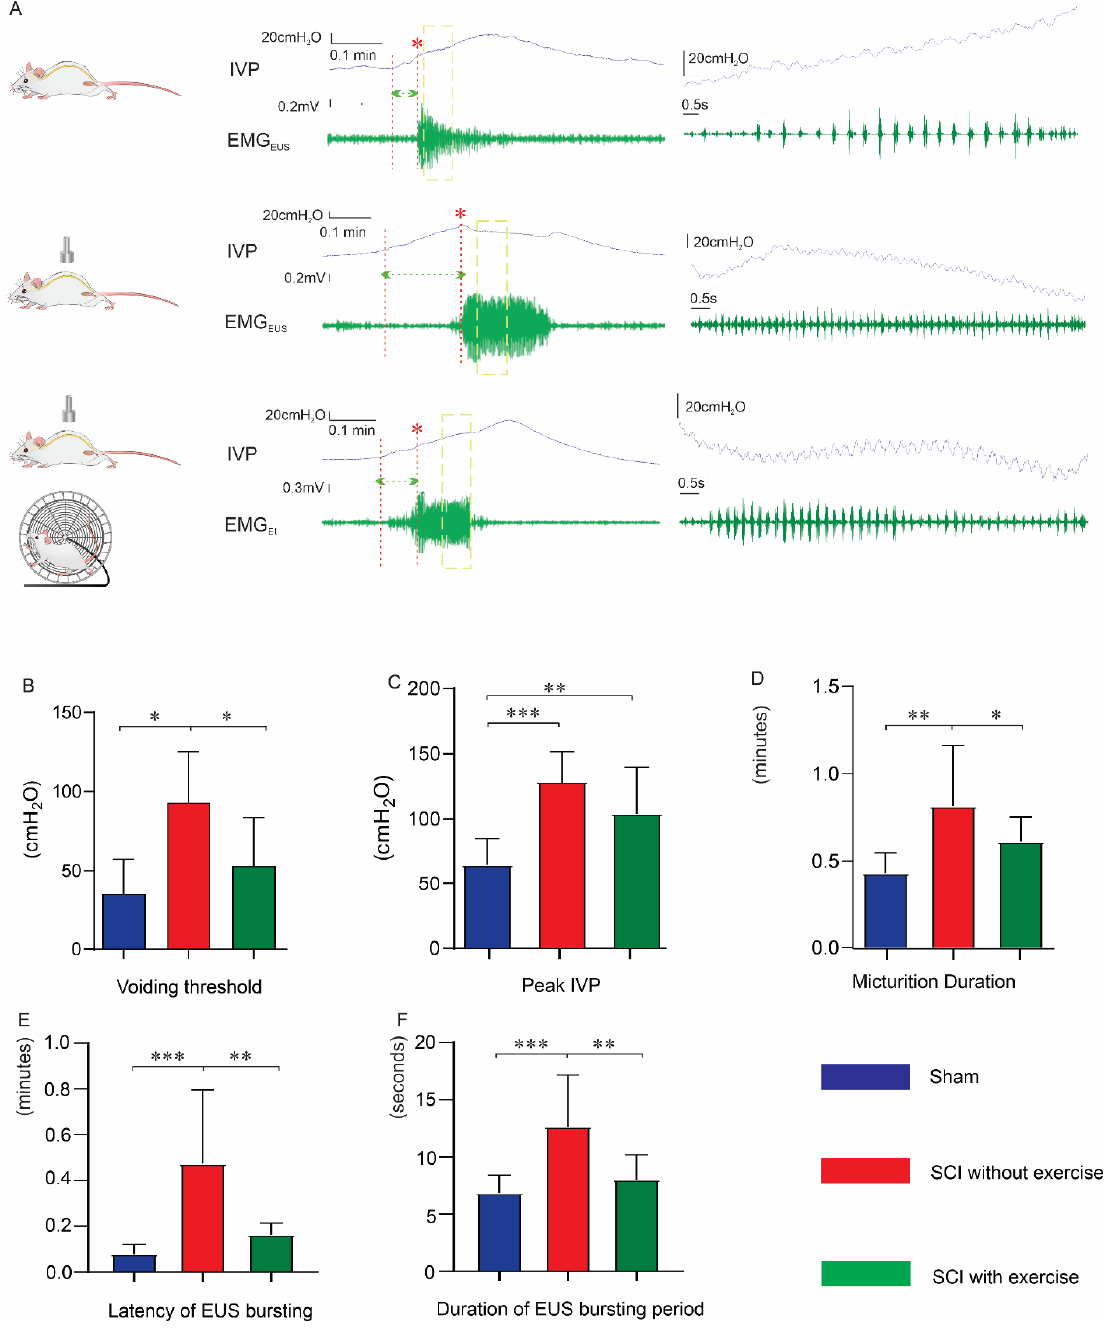
Figure 4. Locomotor exercise improves micturition reflex in continuous voiding recording. ( A ) In terminal awake cystometry, the representative tracing of a raw recording of continuous voiding from a rat in different groups. Each IVP trace (blue) was accompanied with simultaneous recording of EMG EUS (green). Red asterisks, voiding. Micturition duration measured by time from initial pressure increase to voiding end. Green dashed lines (between two red dashed lines), latency of EUS bursting. Bar graphs, compared with SCI without exercise, exercise reduced voiding threshold ( B ), peak IVP ( C ), micturition duration ( D ), latency ( E ), and duration of EUS bursting ( F ). Time-stretched recordings within yellow boxes in each trace shown in the right panels. Each trace contains high-frequency oscillation of bladder contractions and bursting EUS activity during voiding. *: p < 0.05; **: p < 0.01; ***: p < 0.001.